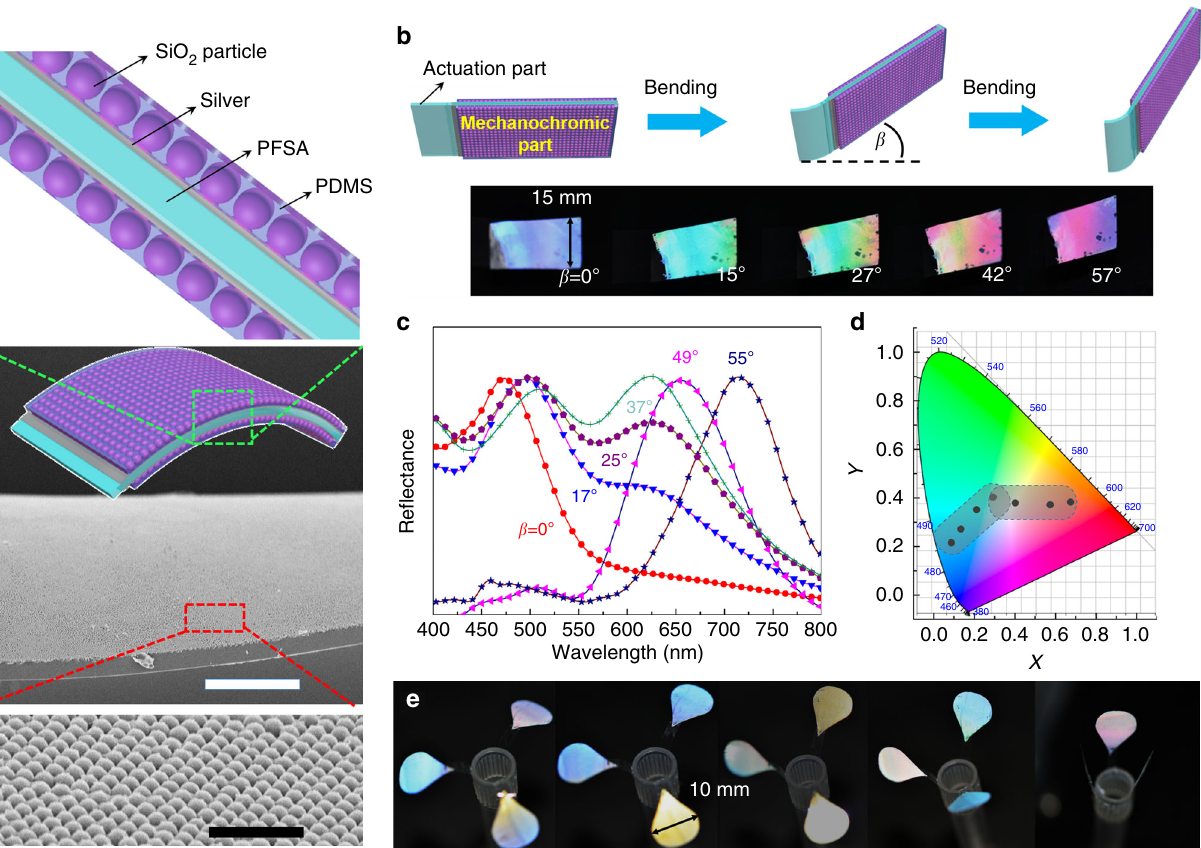
Fig. 6 Stimuli-responsive color change actuator. a Schematic illustration of the cross-sectional structure of the stimuli-responsive color change actuator, and SEM images of a colloidal crystal layer. b Schematic illustration and photograph of the stimuli-responsive color change actuator. The composite fi lm exhibited a range of bending deformity and changed color with an increase in relative humidity. c Measured angle-resolved specular re fl ection of the color change actuator. In the specular re fl ection measurements, the incident light is normal to the sample surface. d The color coordinates were calculated and displayed (black symbols) on a CIE-1931 color space chromaticity diagram. e A smart fl ower fabricated by stimuli-responsive color change actuator, which can change its shape and color depending on the